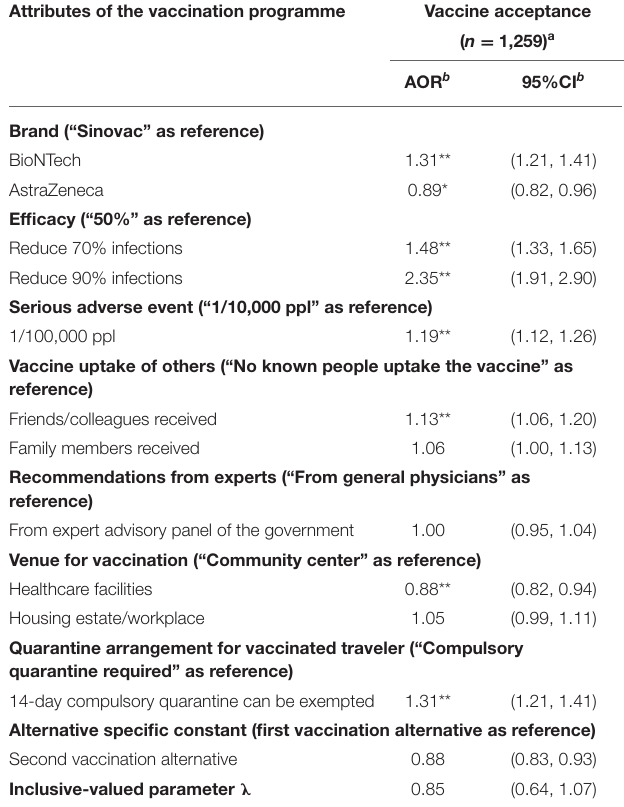
TABLE 4 | Nested logit model results for the effect of vaccination attributes on vaccine acceptance elicited in discrete choice experiment. Attributes of the vaccination